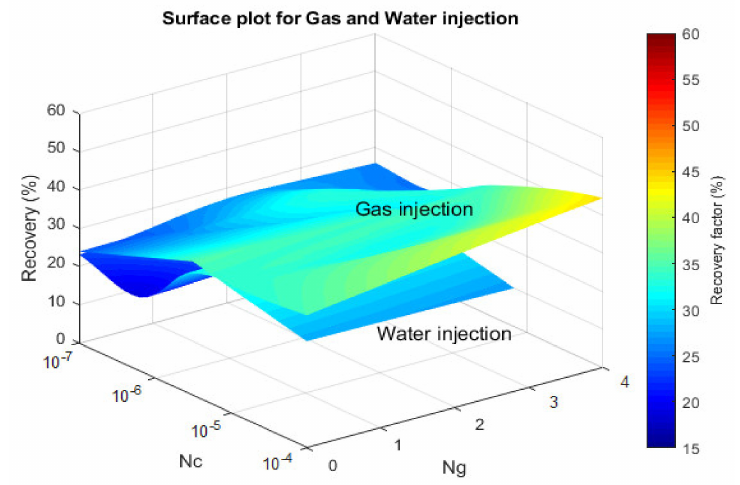
Figure 9. Surface plots of gas and water